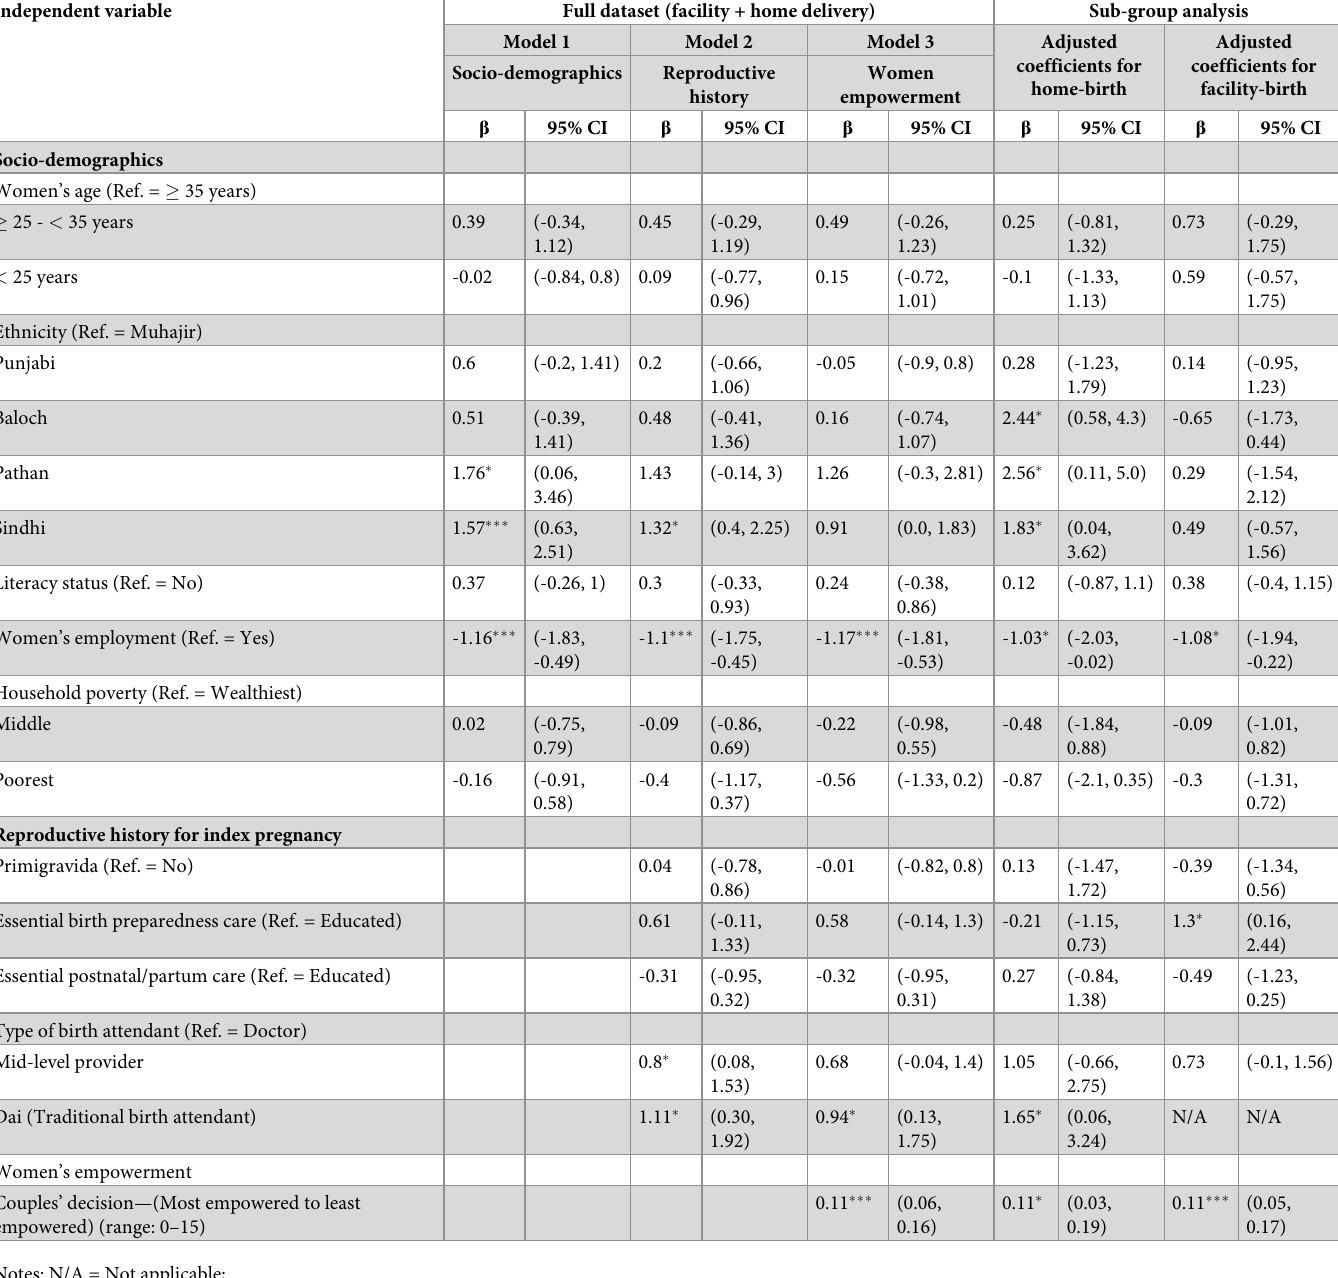
Table 3. Unadjusted and adjusted beta for mistreatment (discrete outcome) by sample